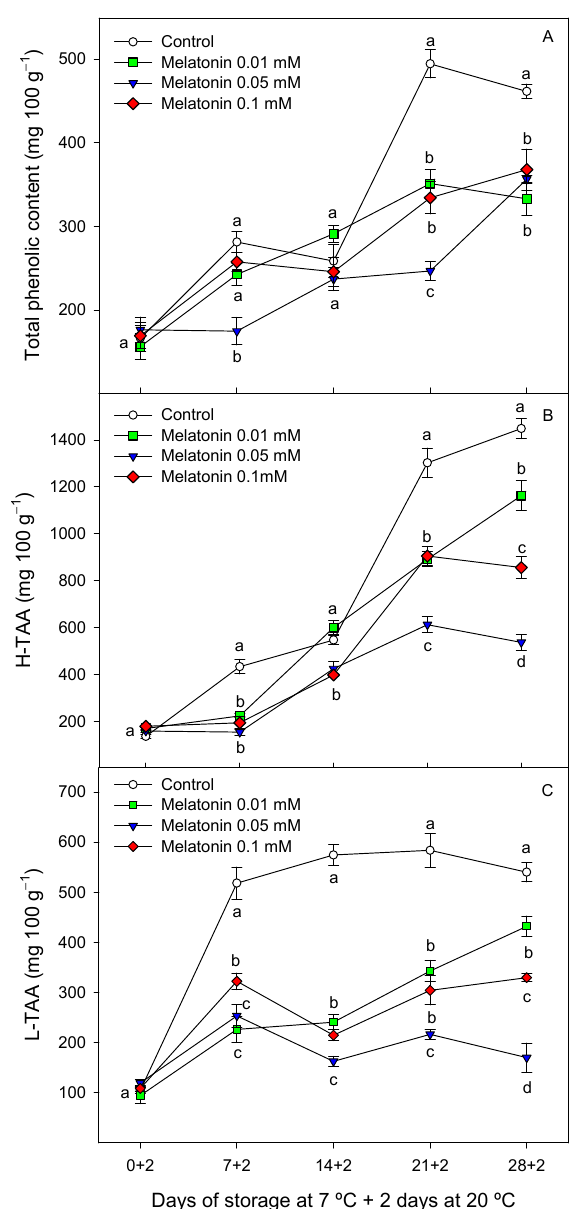
Figure 4. Total phenolic content ( A ), hydrophilic antioxidant activity (H-AA, ( B )) and lipophilic antioxidant activity (L-AA, ( C )) in cherimoya peel as affected by melatonin (0.01, 0.05 and 0.1 mM) treatments. Data are the mean ± SE of three replicates. Different letters show significant differences ( p < 0.05) among treatments for each sampling date.